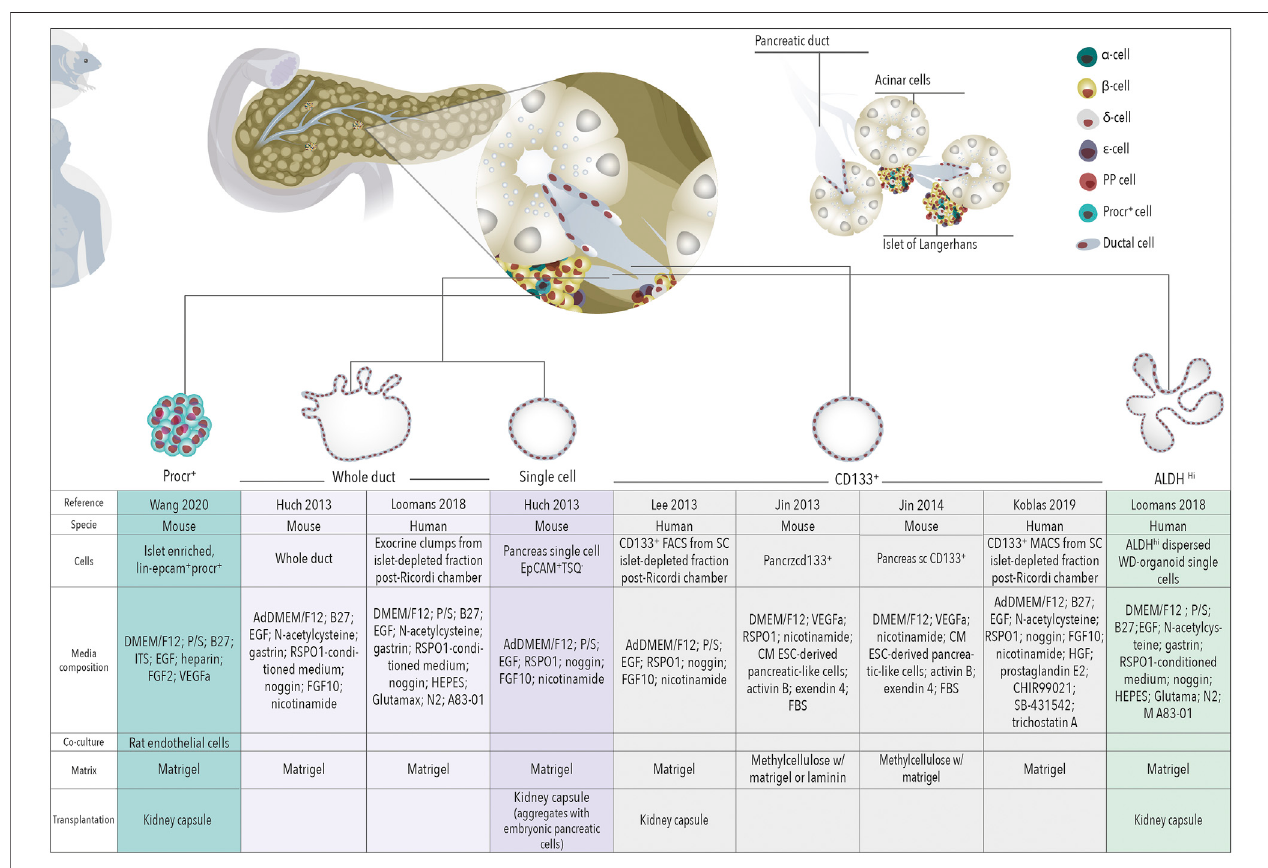
FIGURE 1 | Organoids for regenerative medicine. Schematic representation of organoids derived from different cells of the healthy pancreas towards regenerative medicine for β cell replacement.